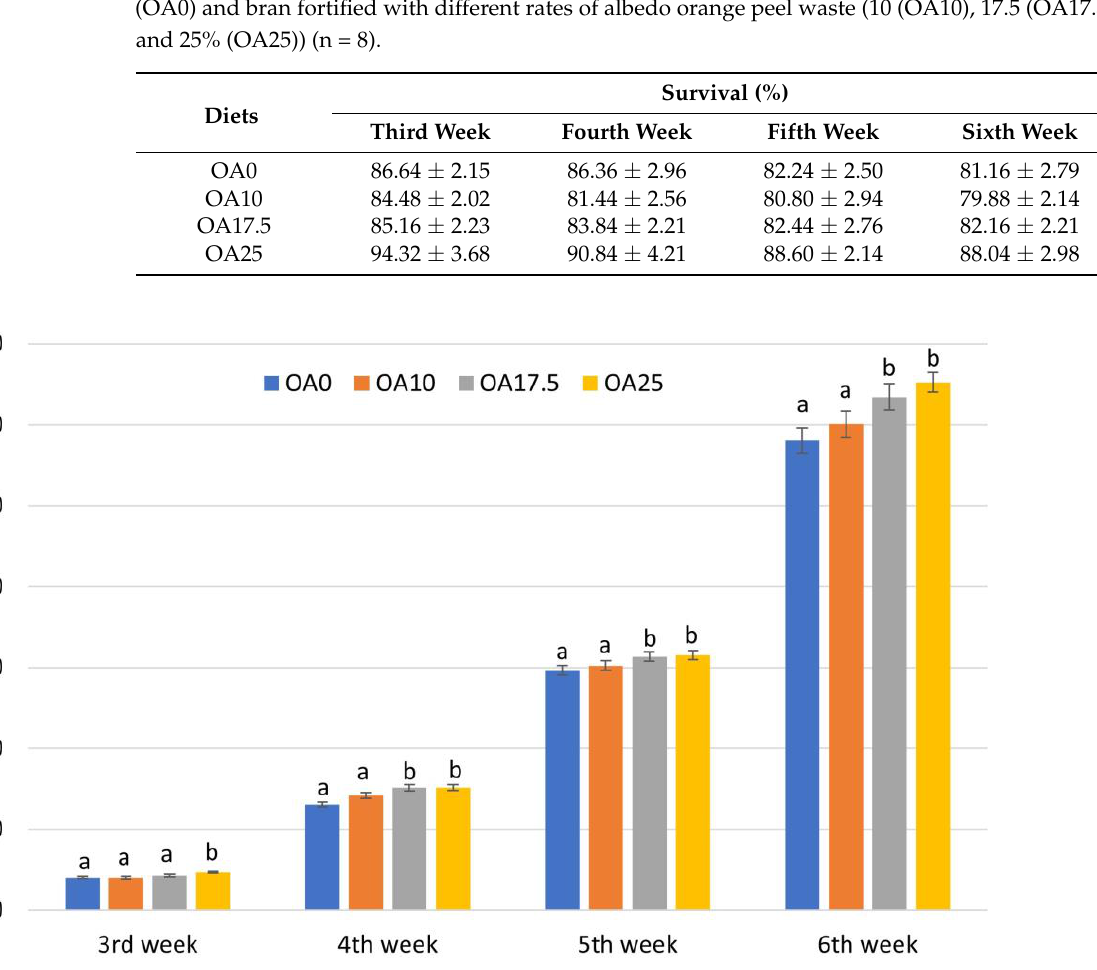
Table 1. Survival (%) of Tenebrio molitor larvae (±SEM) fed for six weeks with wheat bran (control) (OA0) and bran fortified with different rates of albedo orange peel waste (10 (OA10), 17.5 (OA17.5), and 25% (OA25)) (n = 8).